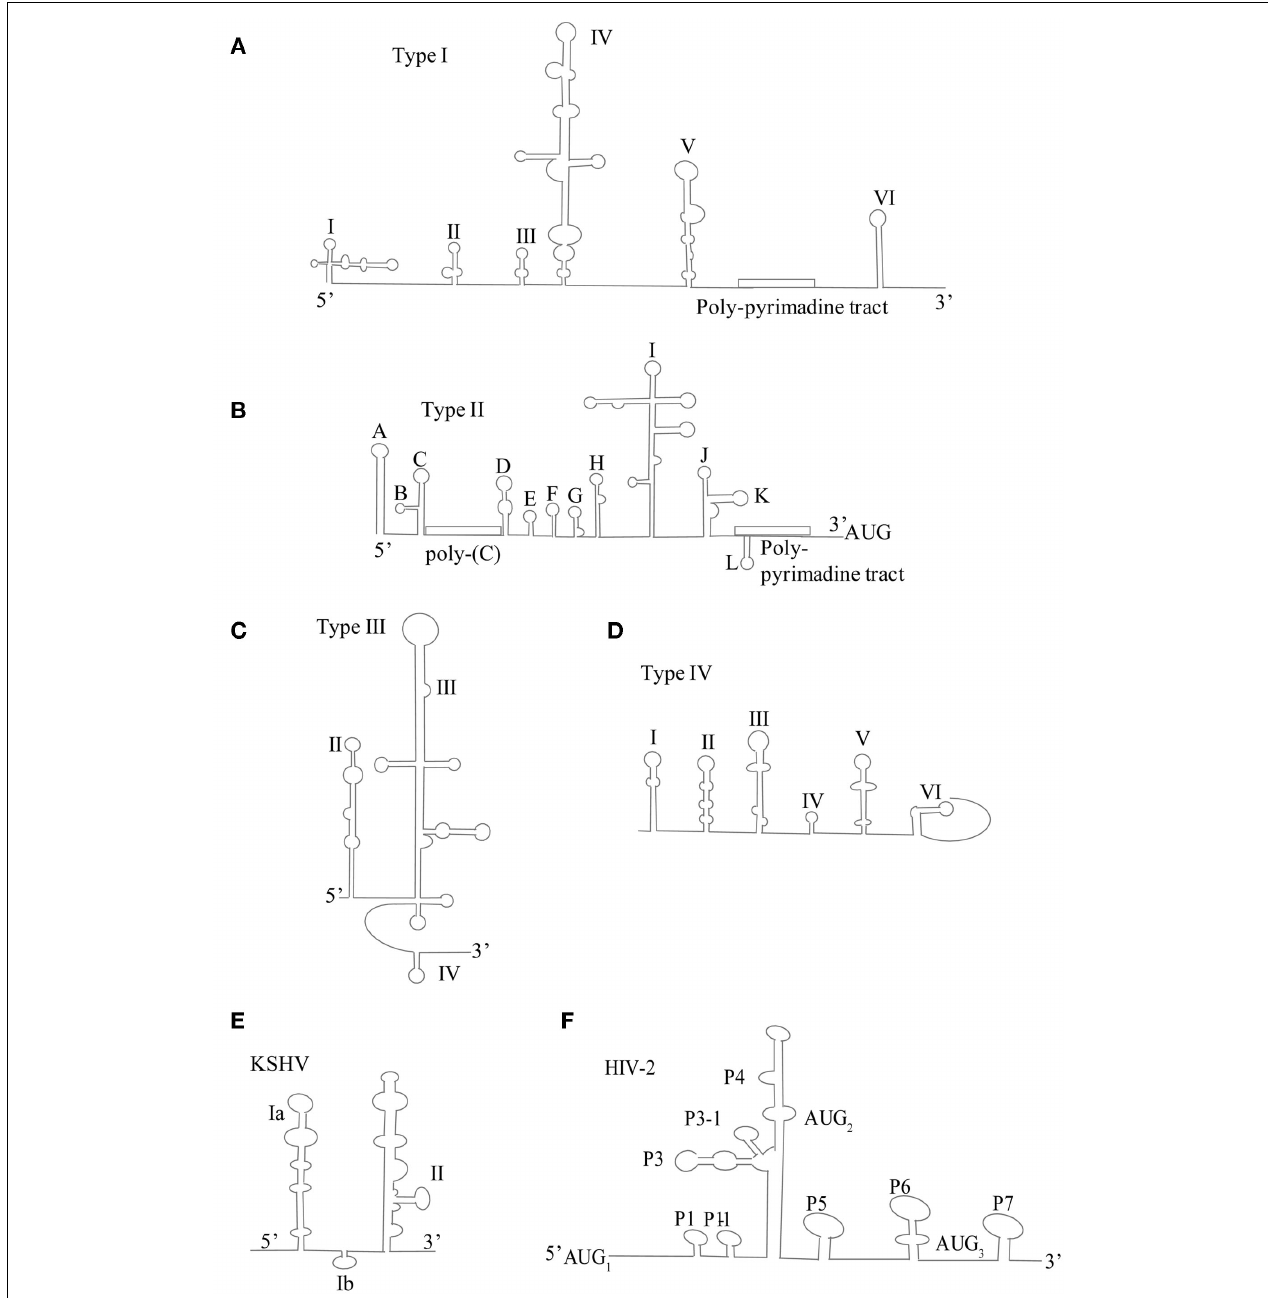
represented by Plautia stali intestine virus (PSIV; adapted from Kanamori and Nakashima, 2001) (E) DNA virus IRES represented by Kaposi’s sarcoma herpesvirus (KSHV; adapted from Beales et al., 2003) (F) HIV IRES, represent by HIV-2 (adapted from Locker et al., 2011).